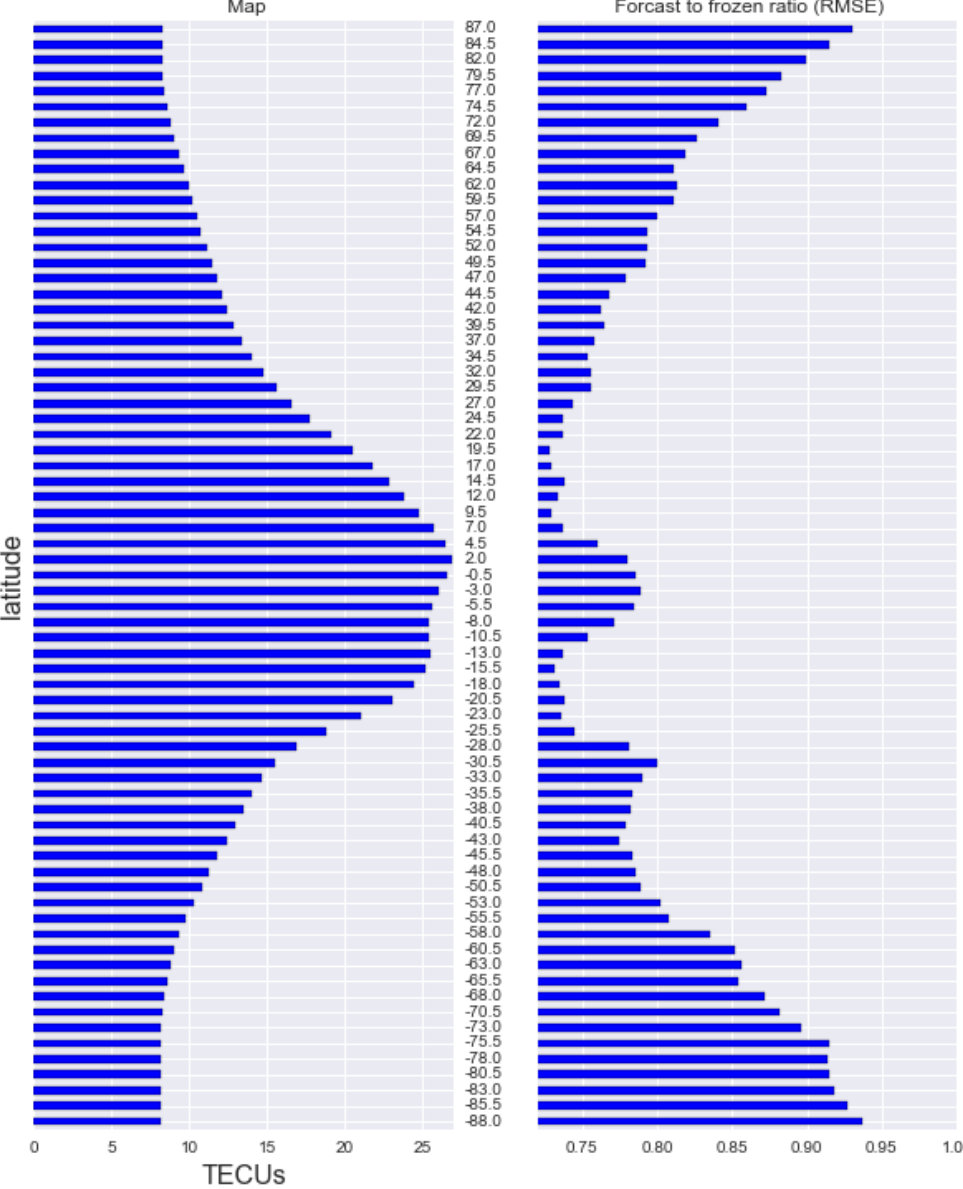
Figure 15. Root Mean Square in TECUs as function of the latitude ( left ). Ratio of RMSE the Tangent Distance Forecast Error to the Frozen forecast error ( right